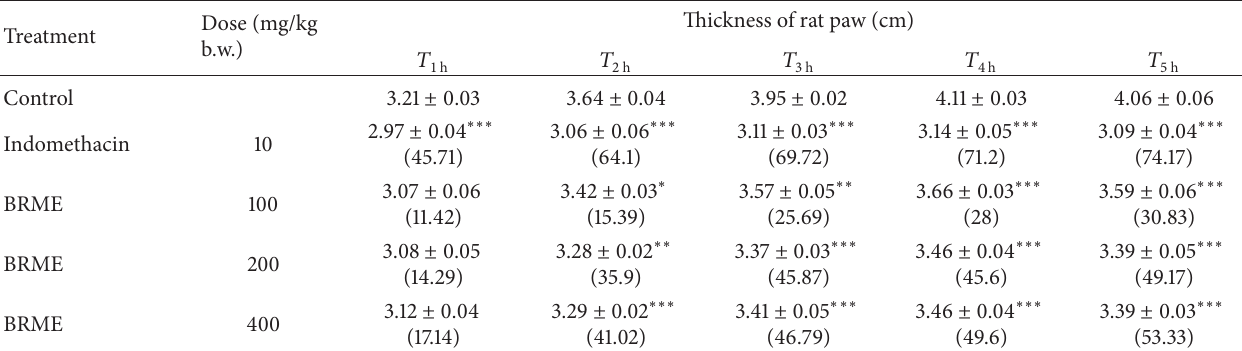
Table 3: Effect of methanolic extract of fruit of Bridelia retusa on serotonin-induced paw oedema. Treatment